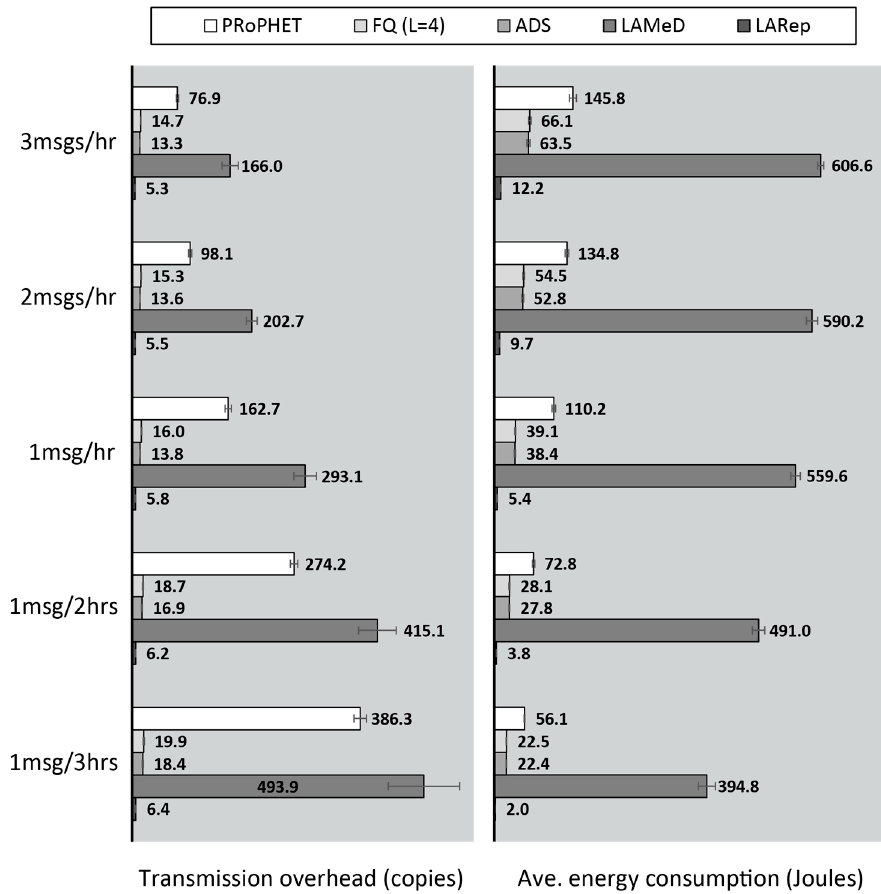
Figure 22. Transmission overhead and average energy consumption under increasing data traffic in the Helsinki scenario.